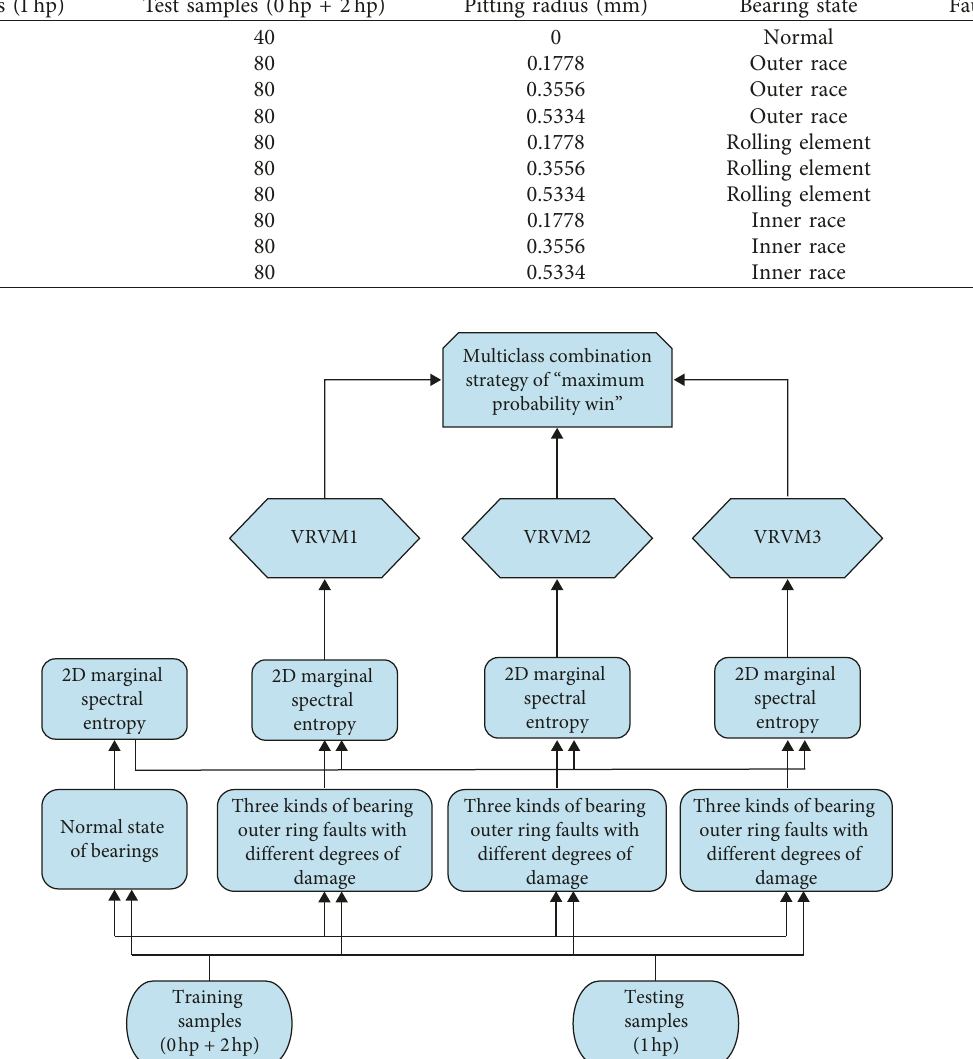
Figure 12: Variable load fault diagnosis process based on